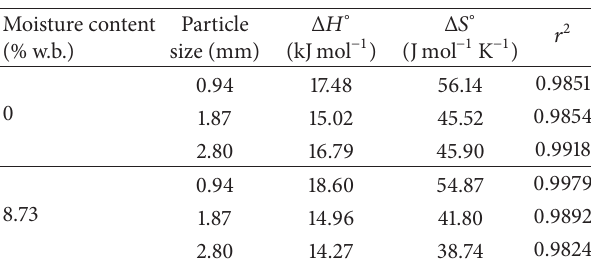
Table 4: Differential enthalpy ( Δ𝐻 ∘ ) and differential entropy ( Δ𝑆 ∘ ) of the oil extraction process for Jatropha seeds with different moisture contents and particle sizes using ethanol as a